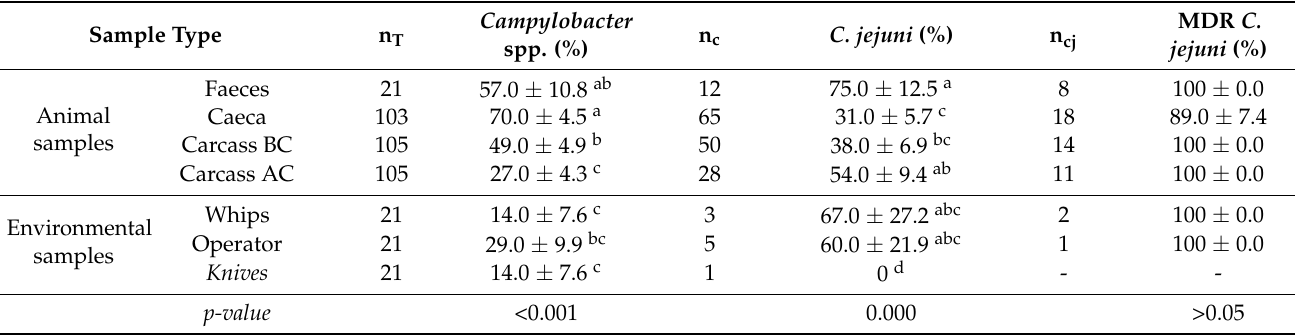
Table 1. Frequency of Campylobacter spp. isolated according to the sample type collected and the relationship with C. jejuni and MDR C. jejuni isolated.